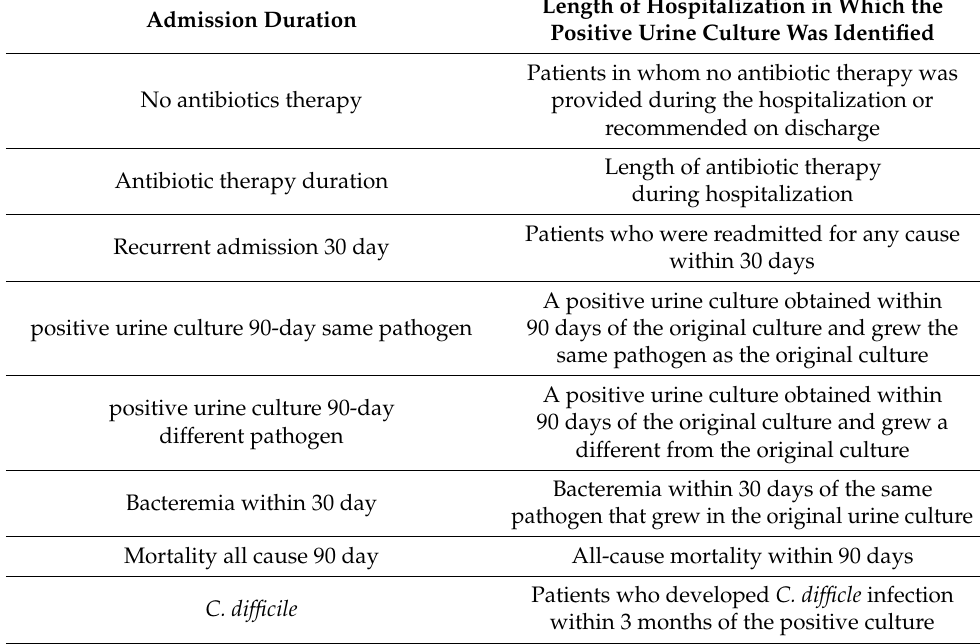
Table 1. Definition of outcomes for the